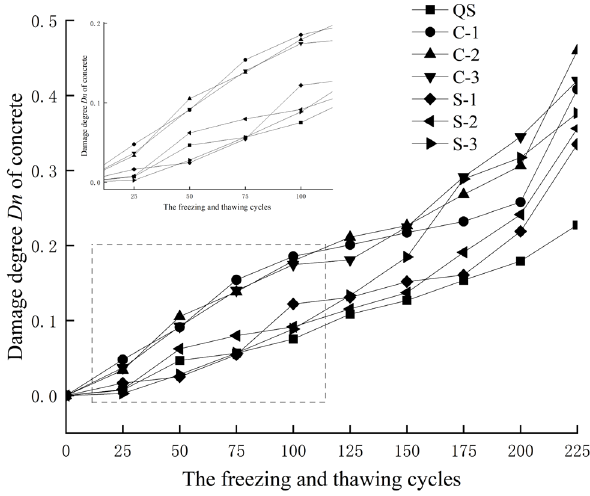
Figure 6: Damage degree D n of concrete.